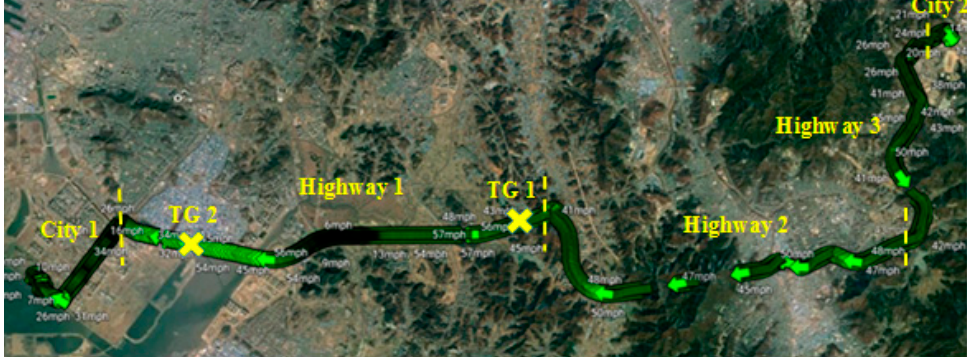
Figure 2. Experiment on the driving route between Incheon and Seoul (captured by Google Earth).